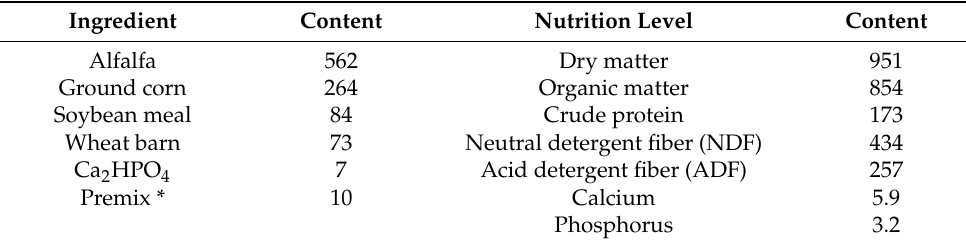
Table 1. The ingredients and nutritional composition (g/kg) of the